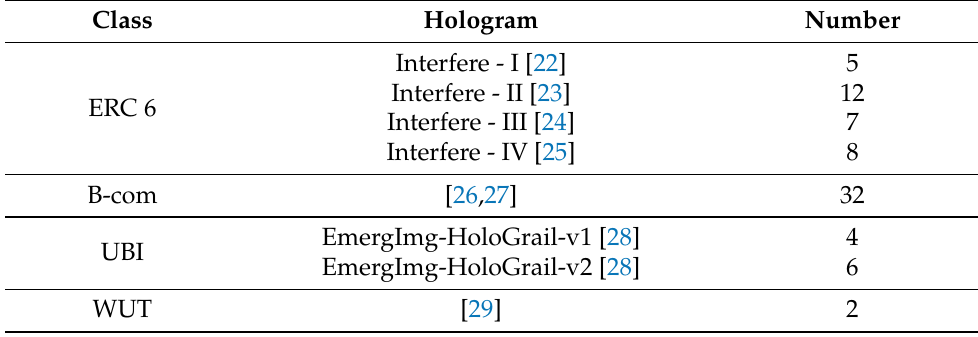
Table 1. Structure of the JPEG Pleno